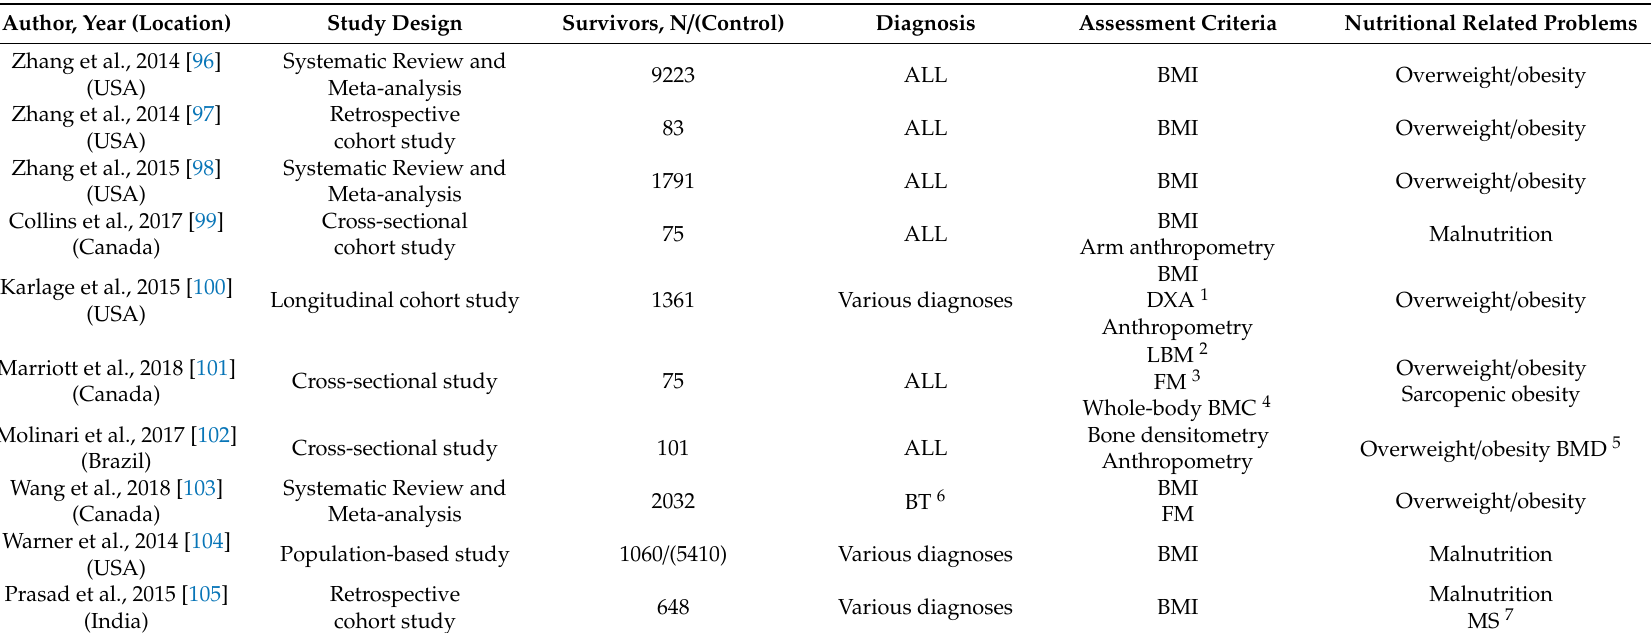
Table 2. Characteristics of listed studies that assess NS in